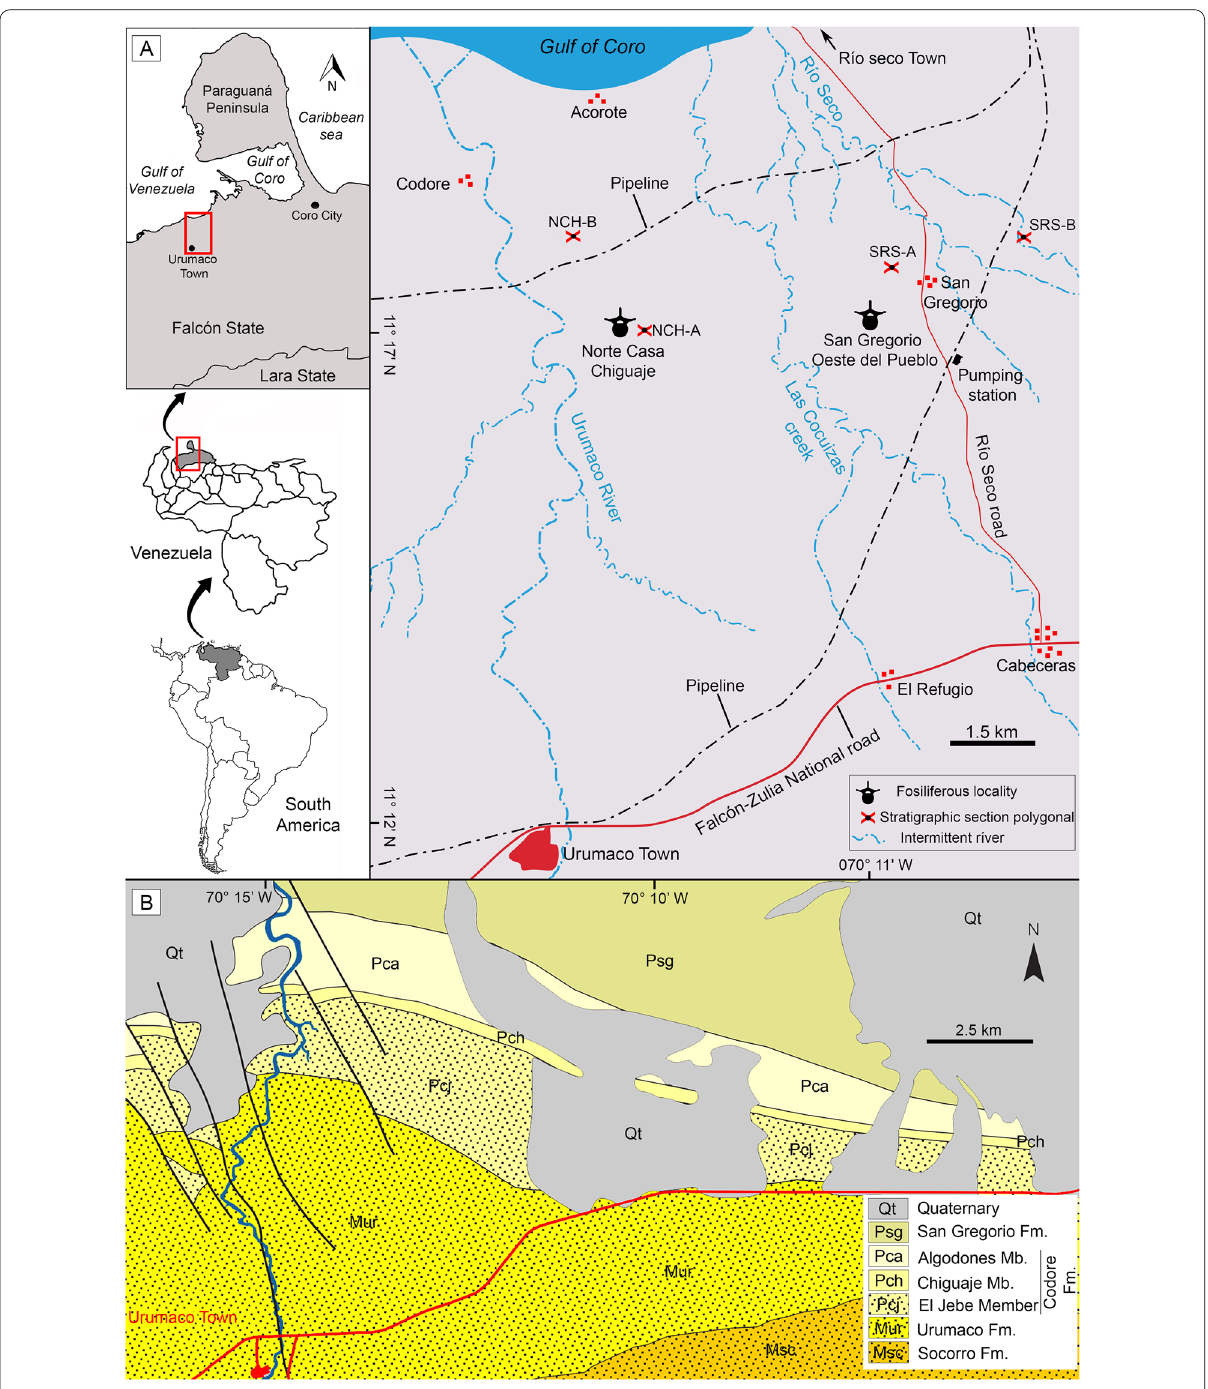
Fig. 1 Geographical and geological location. A Location map of the fossiliferous localities of the San Gregorio Formation. Stratigraphic section polygonal: Northward Chiguaje Hill “NCH” (see Additional file 1) and San Gregorio Río Seco “SGRS” (see Additional file 2). B Generalized geological map near the town of Urumaco showing the outcropping geological units in the area (modified after Quiroz and Jaramillo 2010). Fm. Formation, Mb.